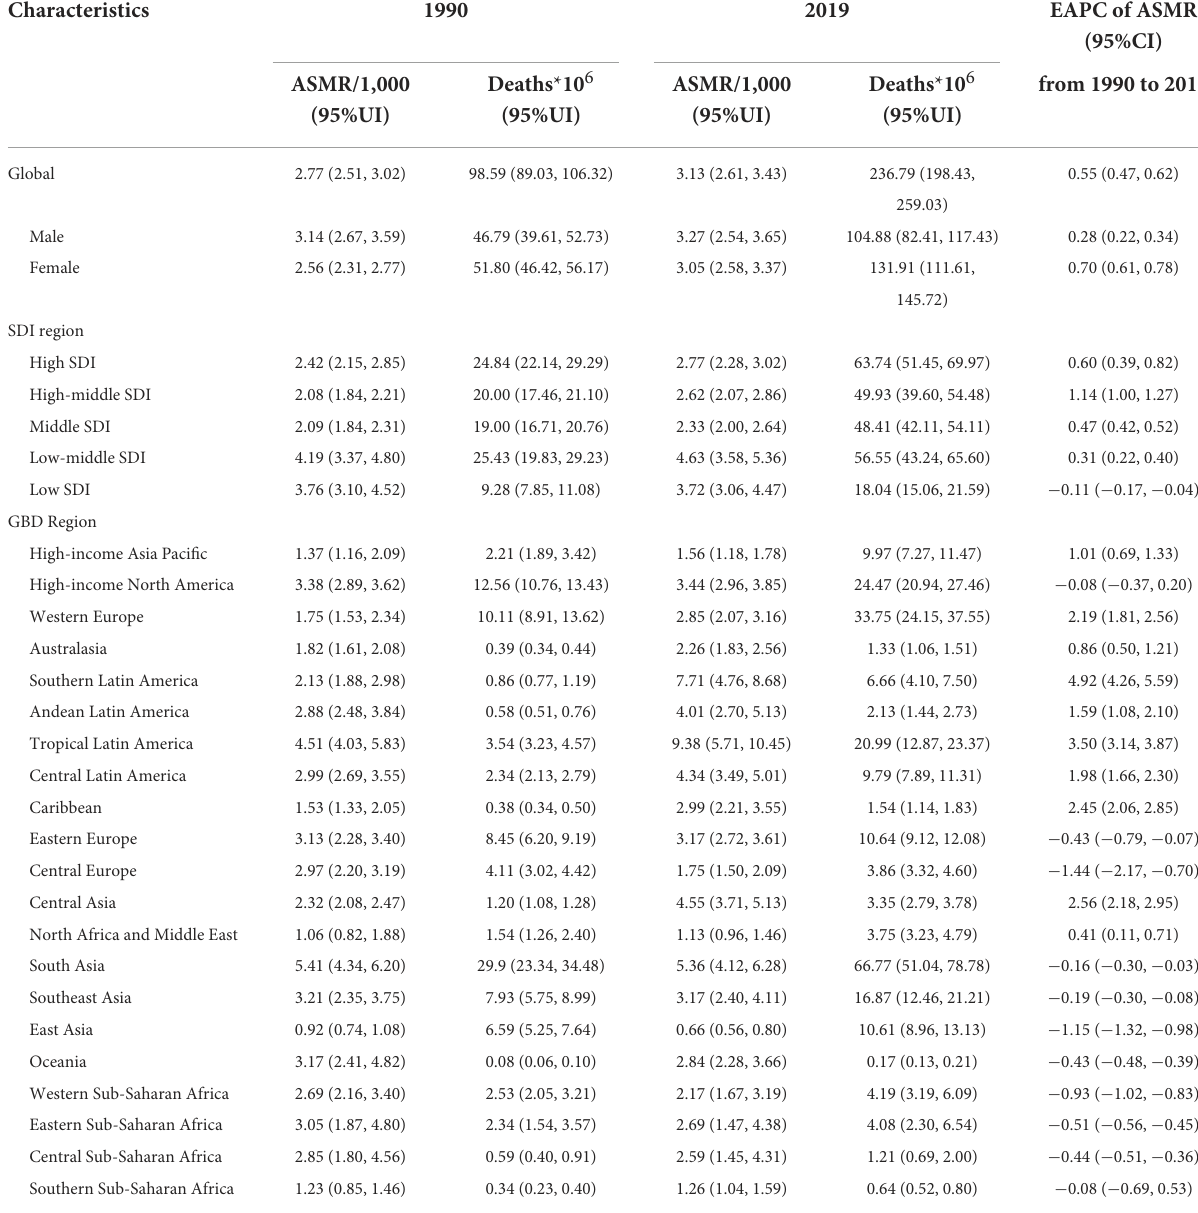
TABLE 1 Deaths and age-standardized mortality rate per 100,000 people for urinary tract infections in 1990 and 2019, and its estimated annual percentage change from 1990 to 2019.